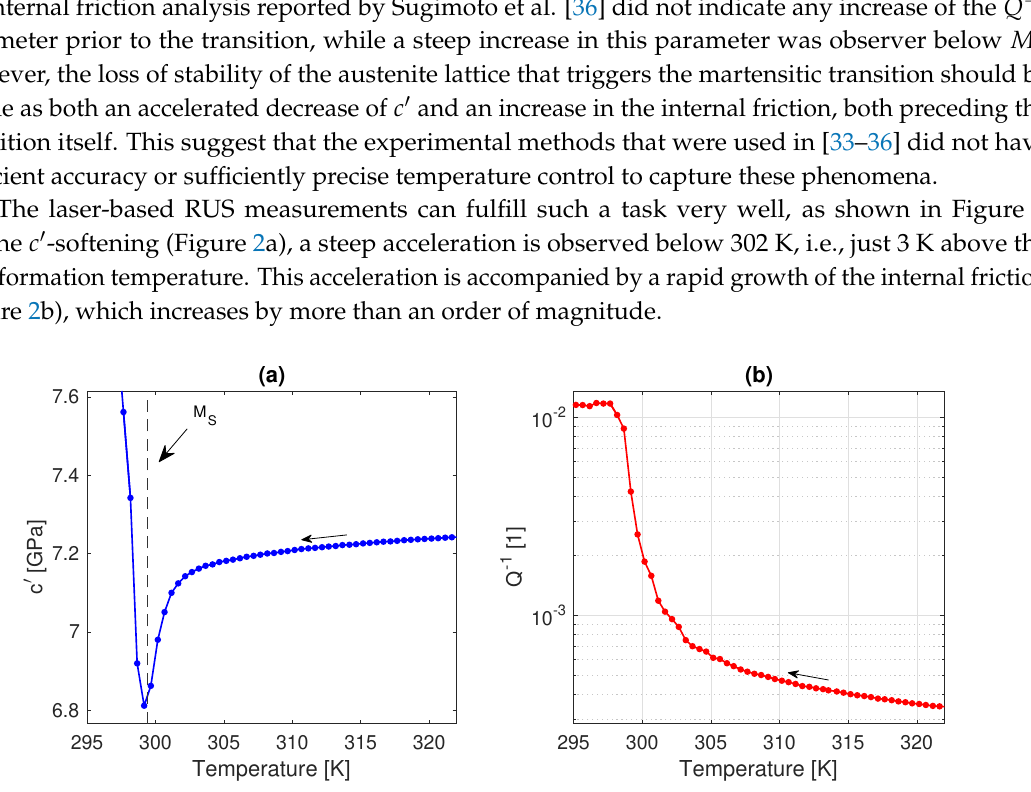
Figure 2. Evolution of the elastic constant c (cid:48) ( a ) and the internal friction parameter ( b ) for the CuAlNi single